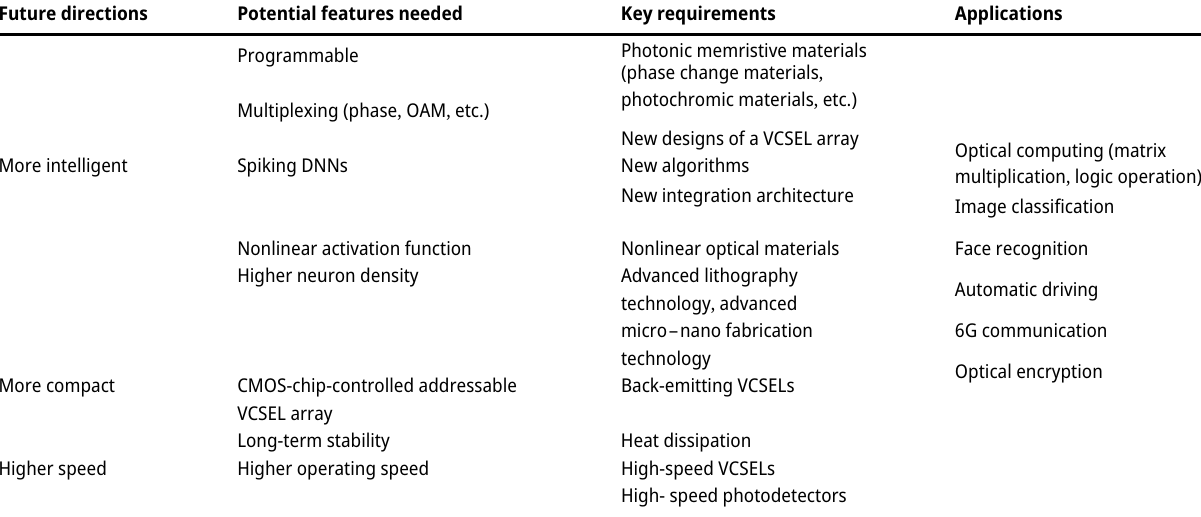
Table 1: Future directions of VCSEL-based 3D photonic chip. Future